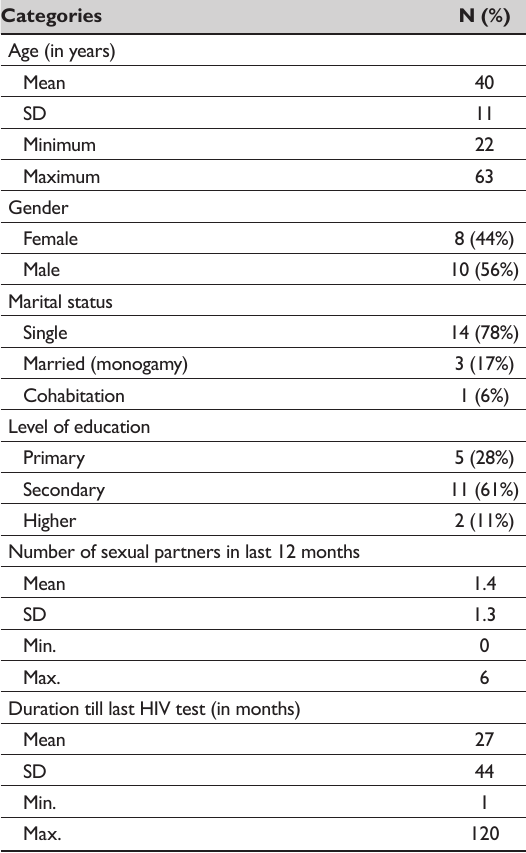
Table 2: Profile of newly-identified cases of HIV in study